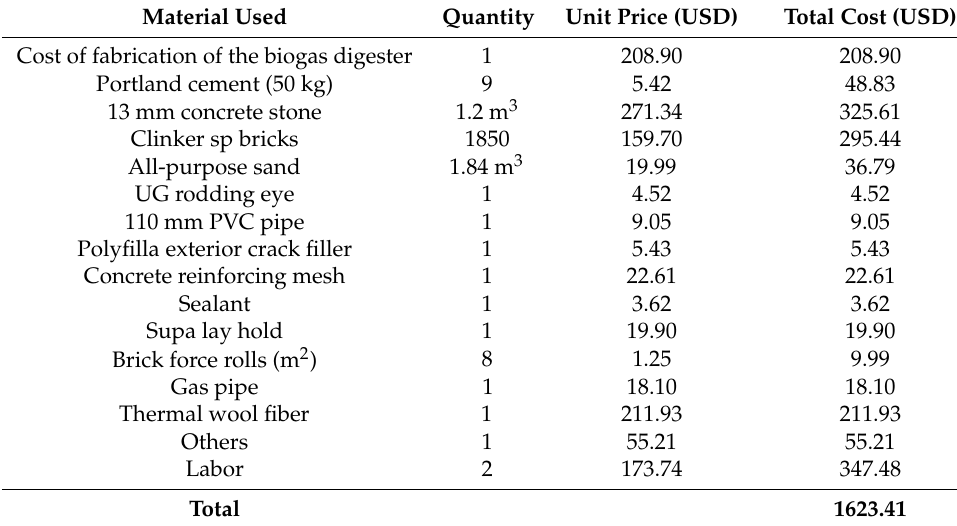
Table 4. Total investment cost of the biogas digester.